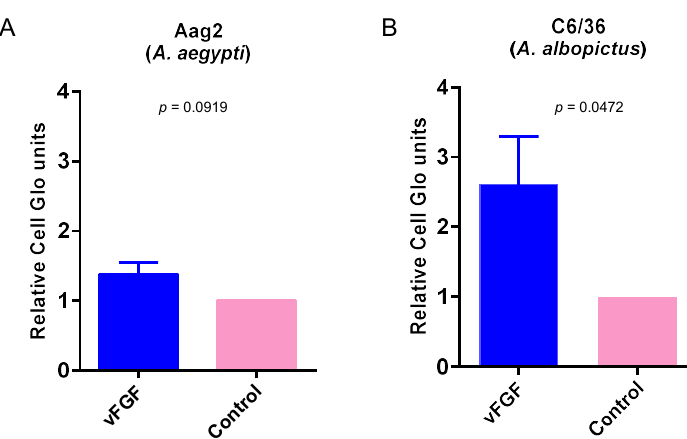
Figure 2. Stimulation of mosquito cell motility by viral fibroblast growth factor (vFGF). vFGF was partially purified from the supernatant of pHSFGFHA-transfected Sf9 cells and used to test its ability to stimulate transmigration of mosquito cells; control proteins were purified by the same method from supernatants of pBluescript-transfected cells. Aag2 ( A ) or C6 / 36 ( B ) cells were plated in the upper chamber of a transwell and cells that migrated towards vFGF or control proteins in the lower compartment of the transwell were measured by CellTiter-Glo. The bars above each column indicate the means ± standard error from three independent experiments. Significance was determined by t test.